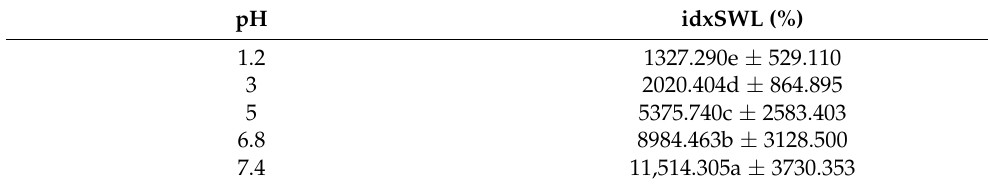
Table 3. Percentage of swelling index (idxSWL (%)) for microspheres as a function of pH factor level.